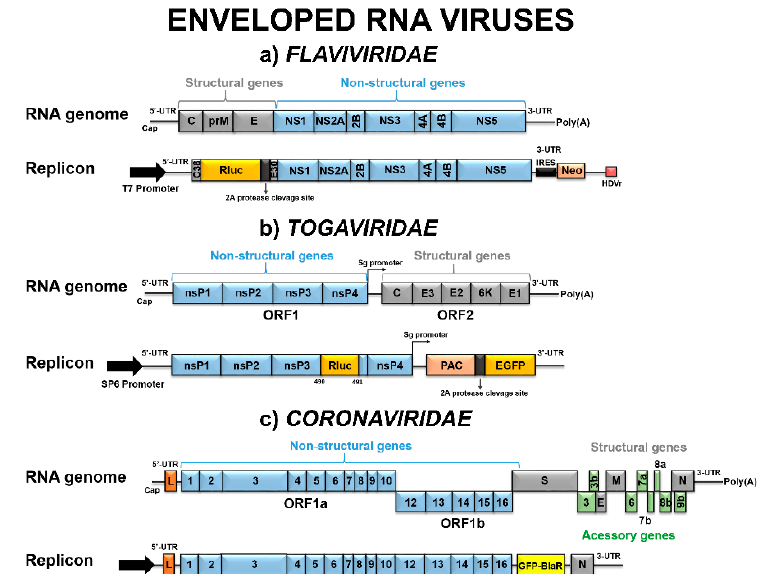
Figure 2. Schematic representation of enveloped RNA viruses’ genome and subgenomic replicon systems. ( a ) Flaviviridae replicon based on the construct described by [8] for the Zika virus (ZIKV). C 38 and E 30 represent DNA sequences encoding the first 38 amino acids of C protein and the last 30 amino